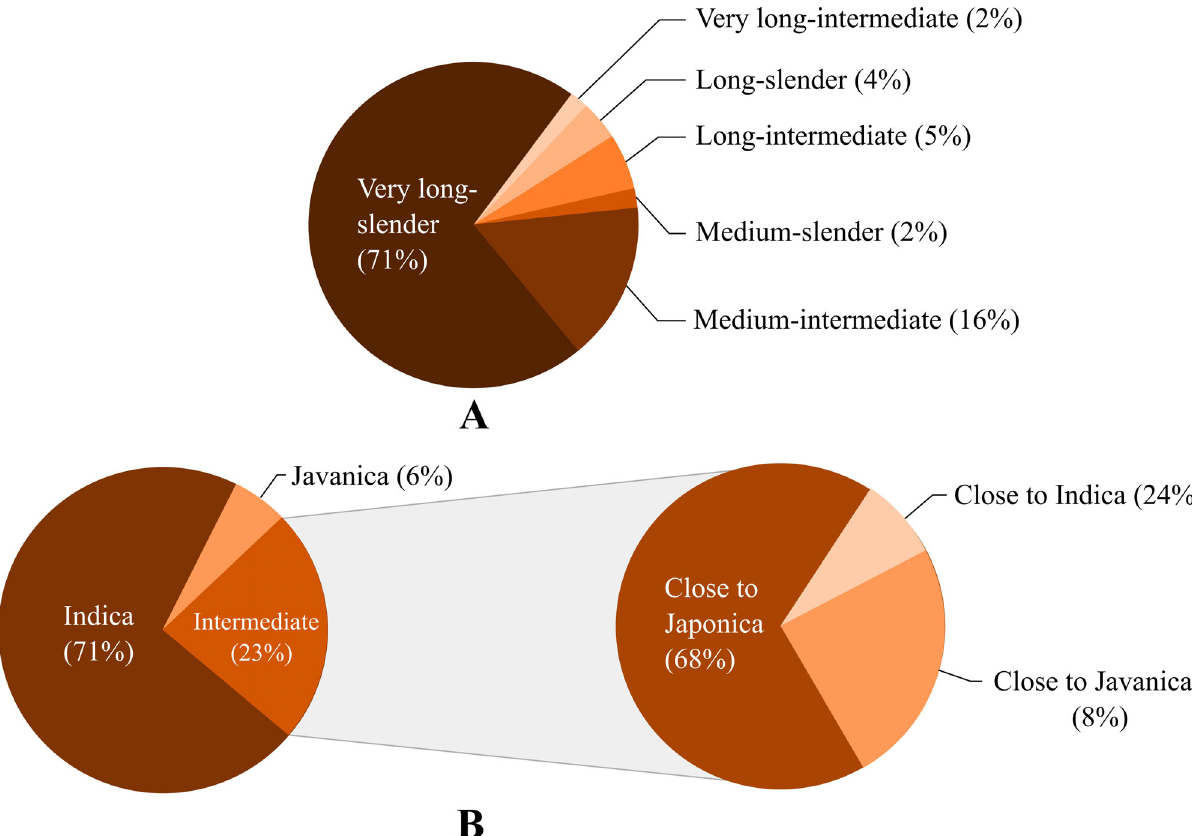
Figure 4. Percentage of Indonesian swamp rice germplasm accessions based on grain shape (A) and sub- species